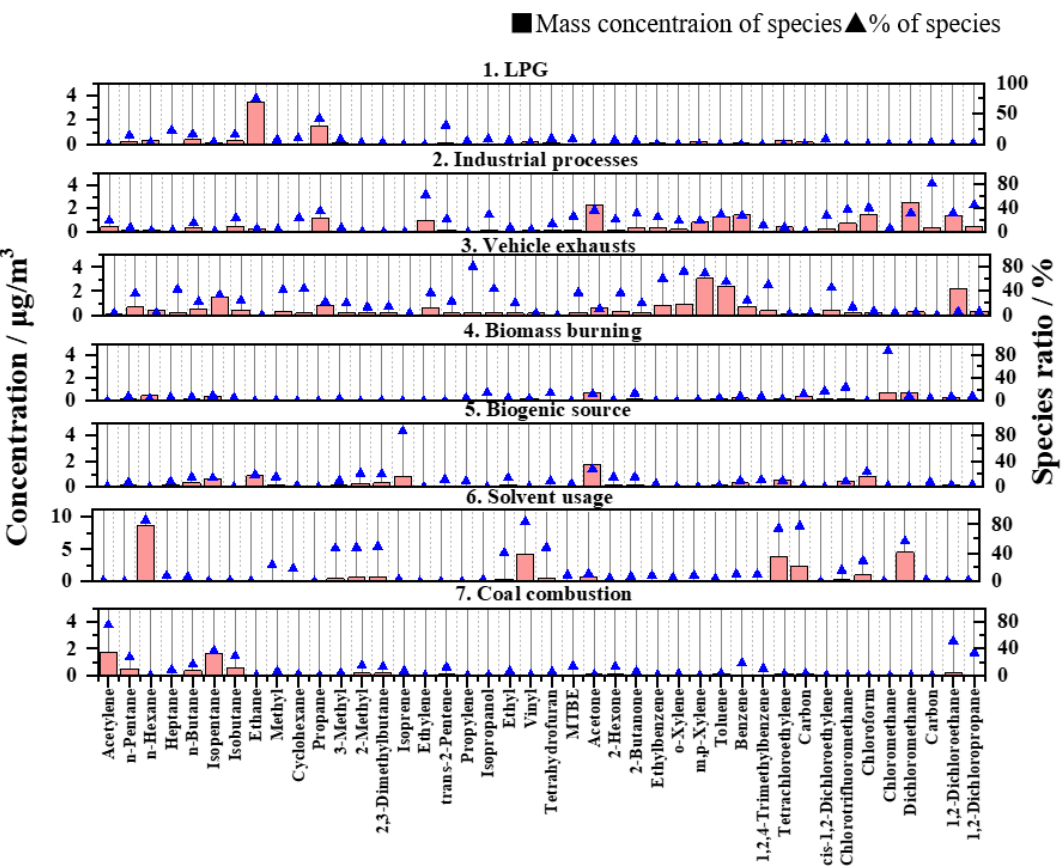
Figure 4. Source profiles calculated using the PMF